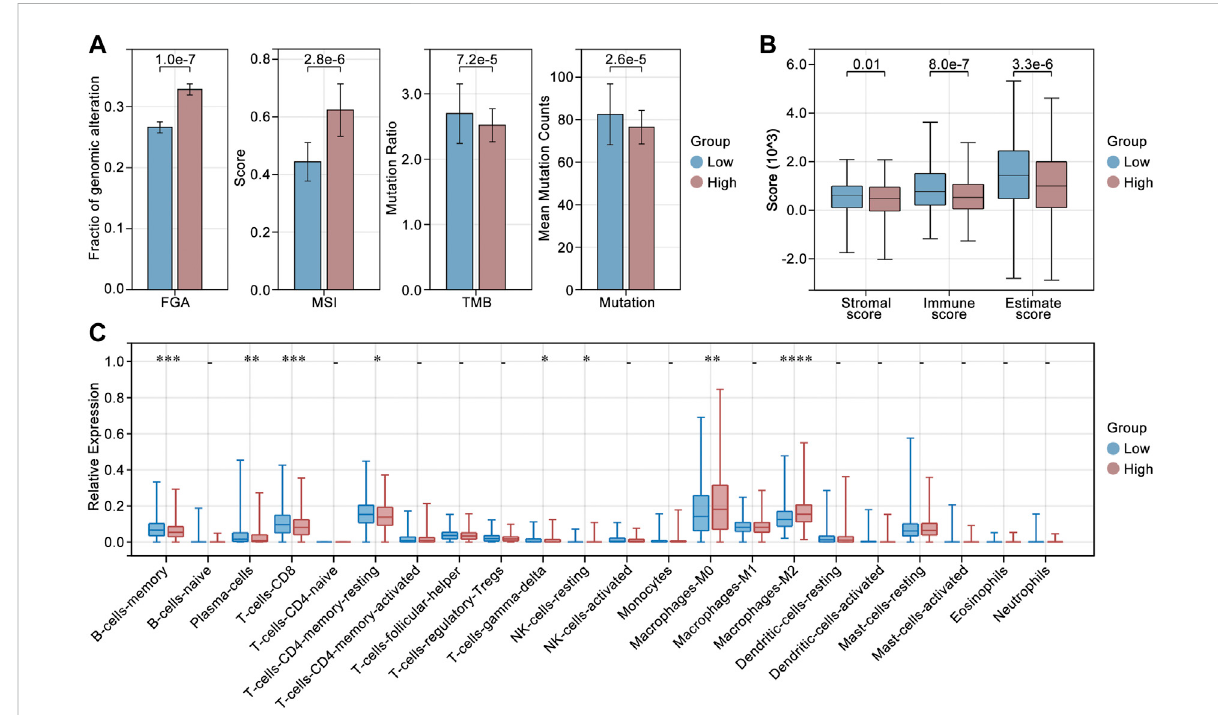
FIGURE 8 Genomic instability and tumor immunity analysis. (A) Differences in fraction of genomic alteration (FGA), microsatellite instability (MSI), gene mutation (mutation) and tumor mutation burden (TMB) in high risk-score and low risk-score groups. (B) Immune score in high risk-score and low risk-score groups. (C) Differences in immune cell in fi ltration in high risk-score and low risk-score